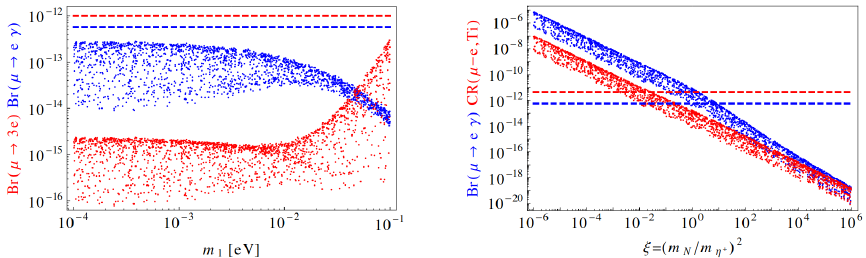
Figure 6. The plots show some CLFV branching fractions in the scotogenic model: in the left plot the prediction for Br ( µ → e γ ) and Br ( µ → 3 e ) for degenerate sterile neutrino masses m N = 4 TeV and m η + = 1 TeV, varying the mass of the lightest neutrino (normal ordering); in the right figure Br ( µ → e γ ) and Br ( µ → e ) conversion as a function of ( m N / m η + ) 2 . The dashed lines correspond to the current experimental upper limit. Yukawas Y η compatible with neutrino parameters are randomly generated (Figure from